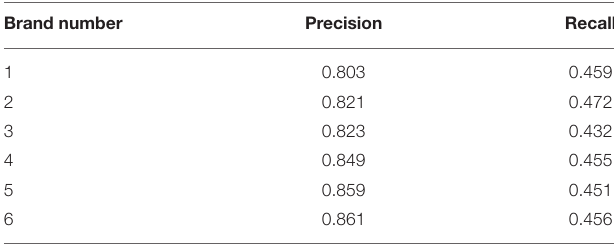
TABLE 6 | Changes of the model along with the quantity of brand